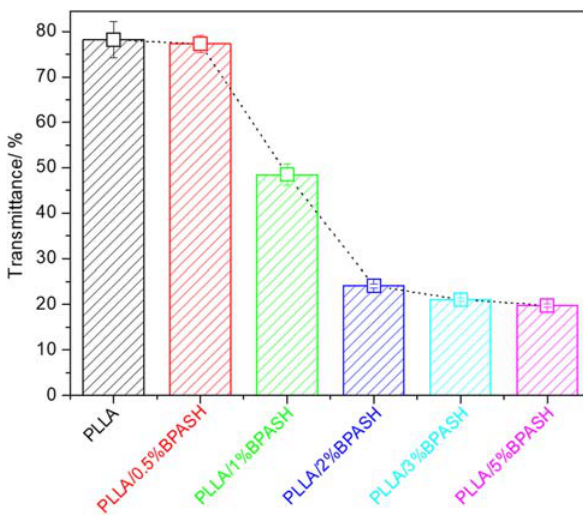
Figure 10: Light transmittance of the virgin PLLA and PLLA/BPASD.